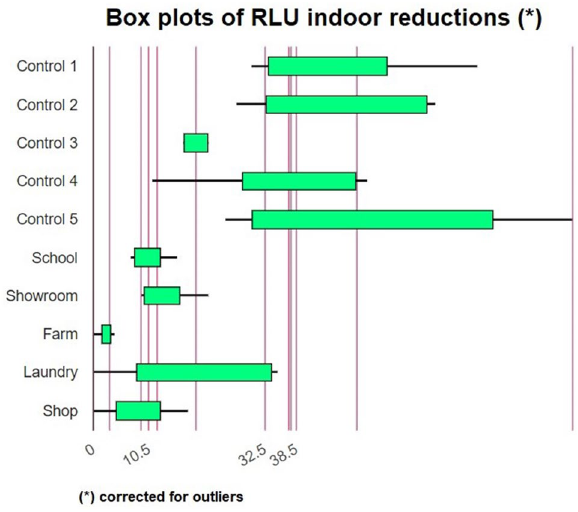
Figure 2. Box plot with means and medians (limits by 95% interval confidence) of the RLU values for controls (evaluations before the application of the TiO 2 -Ag-NP) and data averaged and estimated at the end of the collection. See text for details.